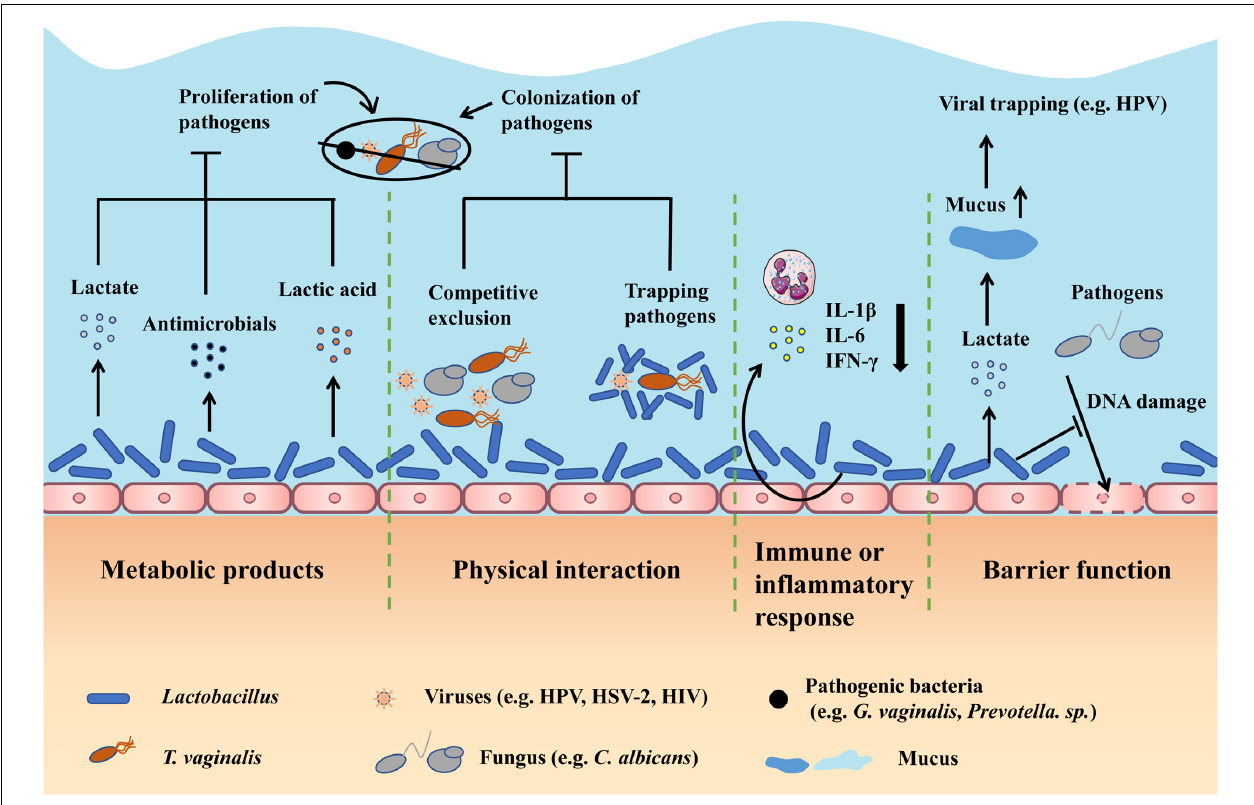
FIGURE 1 | Therapy effects of restoring Lactobacillus -dominated vaginal microbiota in infectious diseases. First, Lactobacillus can produce metabolites including lactate, antimicrobials, and lactic acid to inhibit the proliferation of pathogens. Second, Lactobacillus can competitively exclude pathogens from adhering to epithelium and trap pathogens by direct physical contact to prevent the colonization of pathogens. Third, Lactobacillus can regulate the immune or inflammatory response, particularly relieving the inflammation by decreasing cytokines like IL-1 β . Fourth, Lactobacillus can improve the barrier function by producing lactate, which can increase the mucus viscosity to facilitate viral trapping, and inhibiting pathogens from damaging the DNA of epithelial cells. DNA, deoxyribonucleic